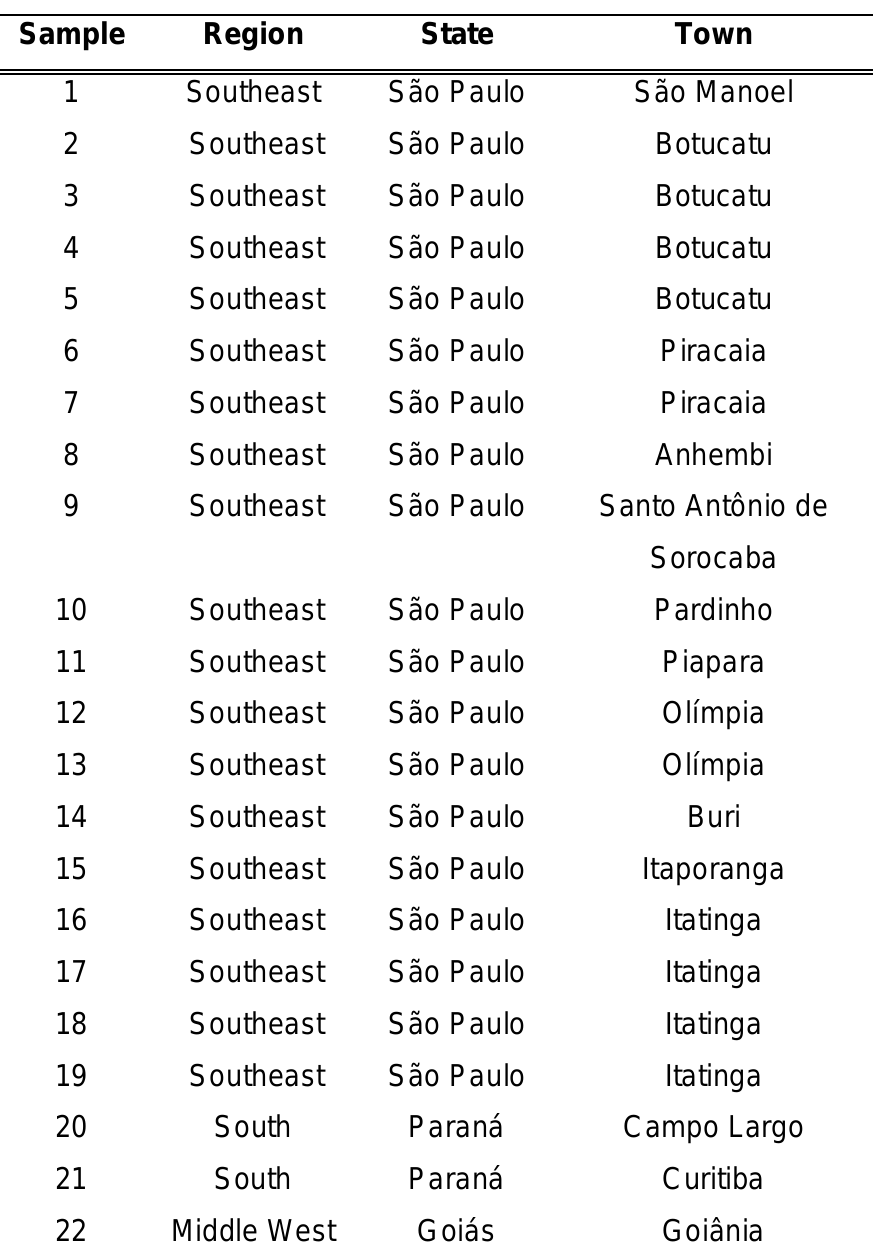
Table 1: Propolis